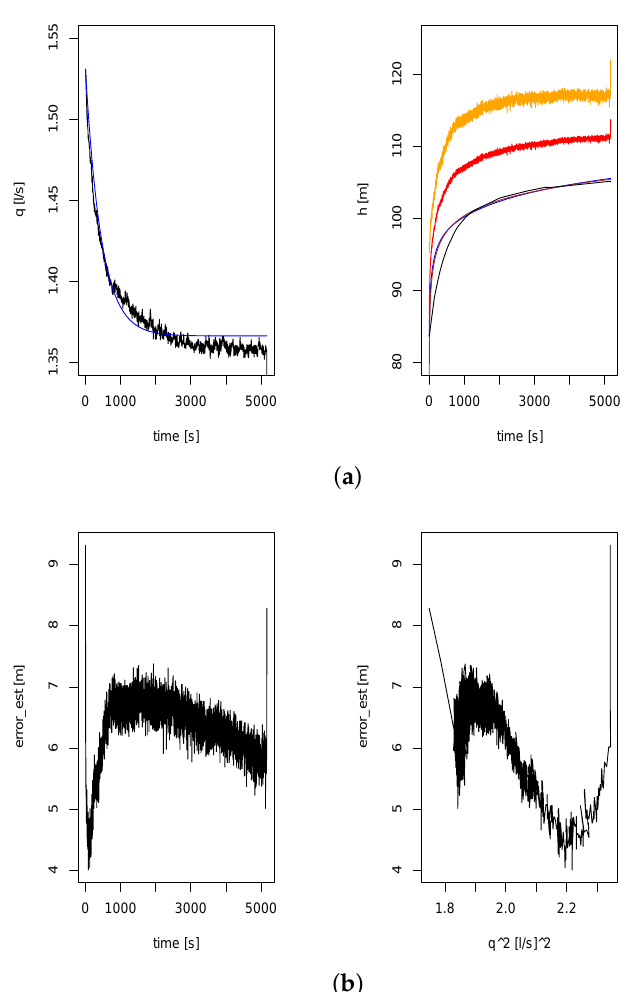
Figure 10. Validation. 2nd set of parameters. ( a ) Left: Water flow evolution, measured (black) and adjusted (blue). Right: Water level evolution, measured (black) and simulated (blue, orange and red). ( b ) Error estimation evolution, left, and relationship with water flow square,